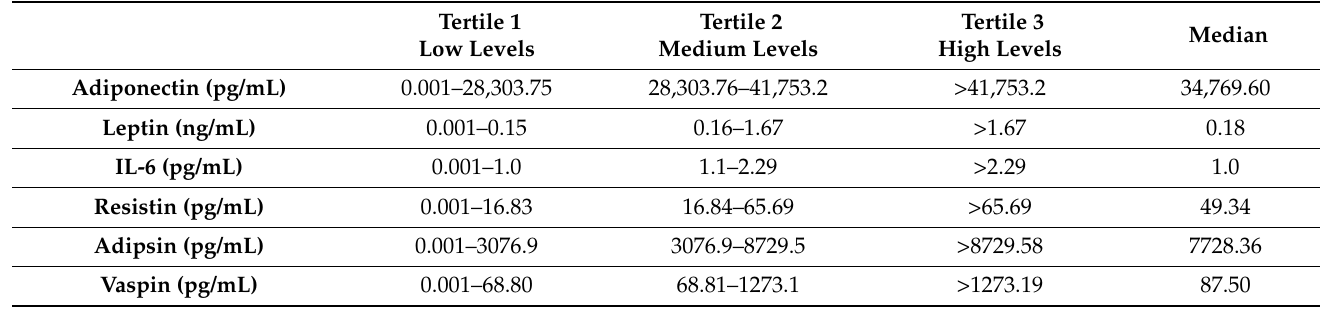
Table 3. Stratification of adipokine levels according to 33rd